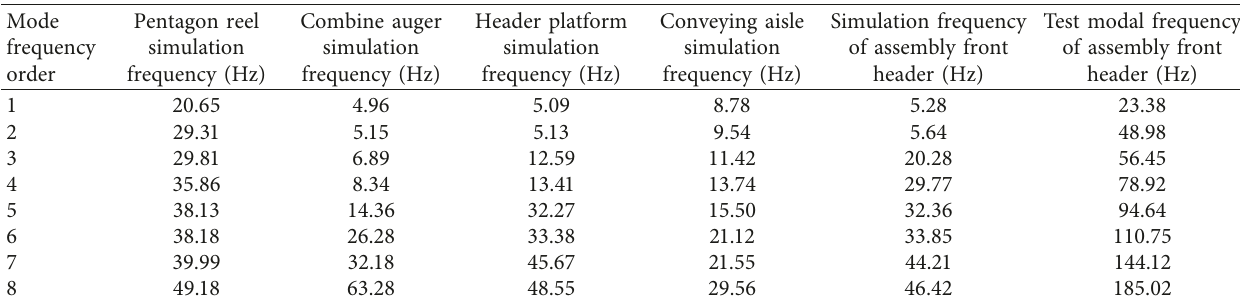
Figure 18: Modal shapes under restricted modality. (a) Pentagon reel. (b) Combine auger. (c) Header platform. (d) Conveyer aisle. Table 3: Mode vibration frequency of various parts of front